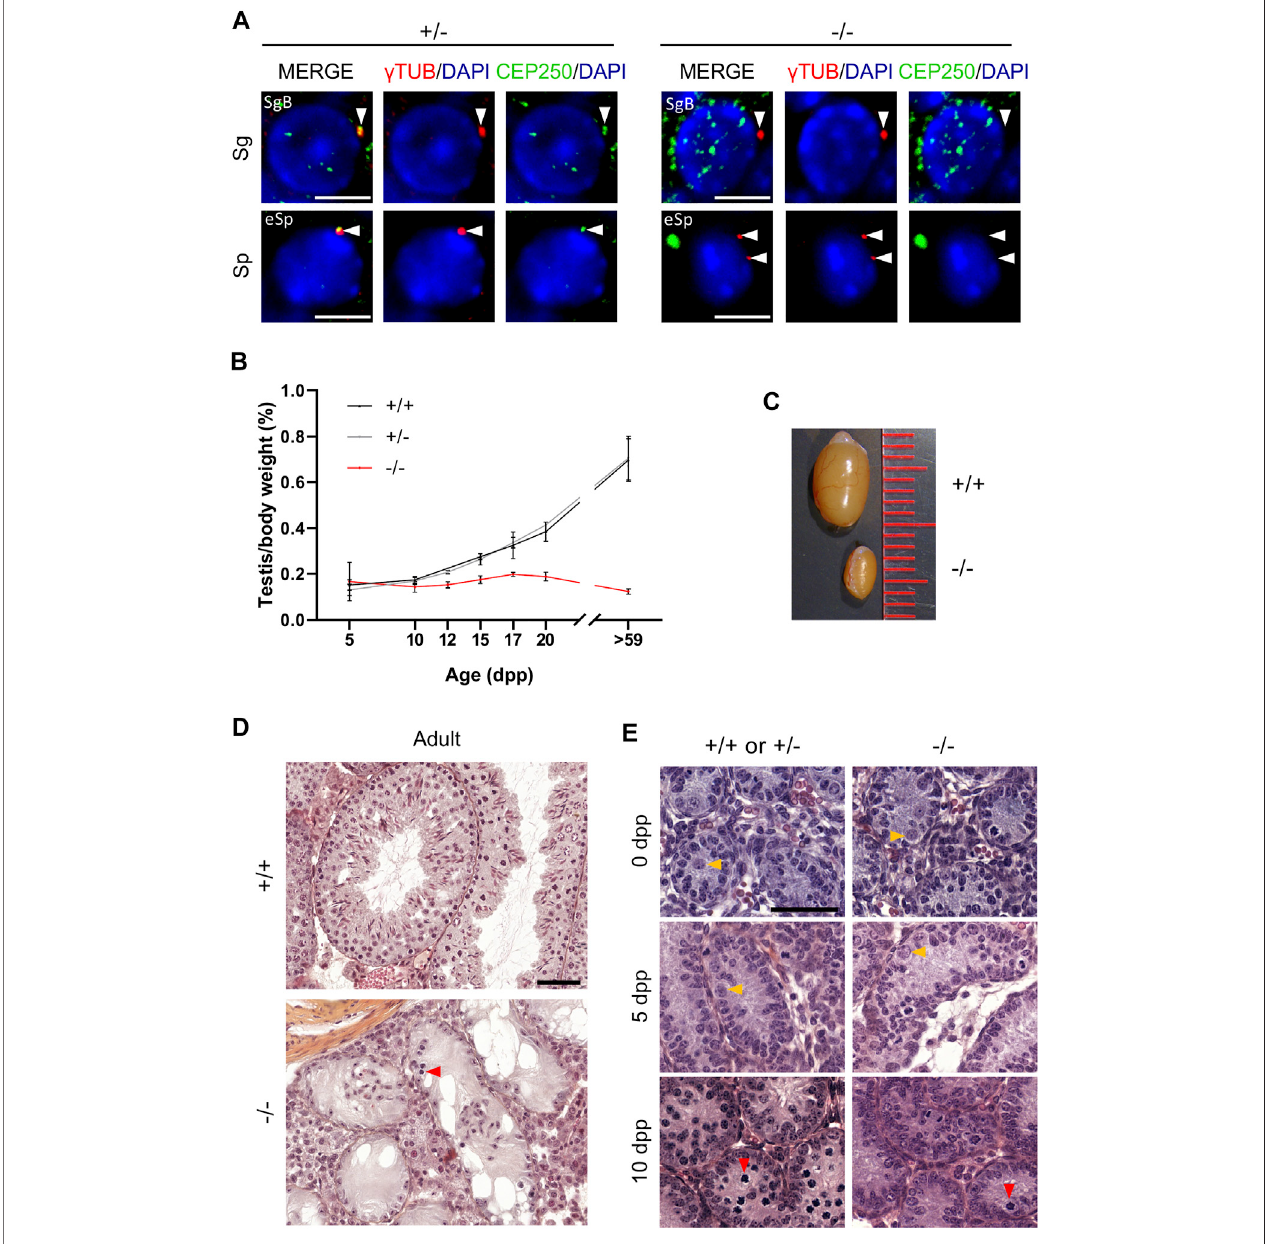
FIGURE 2 | Cep250isrequiredfor post-natalspermatogenesis. (A) Immuno fl uorescence stainingof γ -tubulin ( γ TUB,red)and CEP250(green) inthe control(+/-) and mutant (-/-) testissections. DNA isstained withDAPI. White arrowheads indicate γ -tubulinstained centrosomes. Note that no CEP250staining isobserved in centrosomes frommutantspermatogonia(Sg)orspermatocytes(Sp).SgB,Bspermatogonia;eSp,earlyspermatocytes(leptonematoearlypachynema). Scalebar:5 µm. (B) Analysisof testisweight/bodyweightfrom5to > 59 day-oldwild-type(+/+),heterozygous(+/ − )andhomozygousmutant( − / − )mice.Valuescorrespondtomean ± SD, n (cid:1) 3to25, exceptfor+/ − at12,20and > 59dppand − / − at17dpp( n (cid:1) 2). (C) Adulttestesfrommutant( − / − )micearesmallerthanthecontrol(+/+)adulttestes. (D) Hematoxylin/eosin- stainedsectionsofthecontrol(+/+)andmutant( − / − )adulttestes.Theredarrowheadindicatesaspermatocyteinthemutanttestis.Scalebar:50 µm. (E) Hematoxylin/eosin- stained sections of the control (+/+ or +/ − ) and mutant ( − / − ) testes at the indicated developmental ages (0, 5 and 10 days post-partum, dpp). 0 dpp control is +/+; 5 dpp control is +/ − ; 10 dpp control is +/+. Yellow arrowheads indicate spermatogonia; red arrowheads indicate spermatocytes. Scale bar: 50 µm.